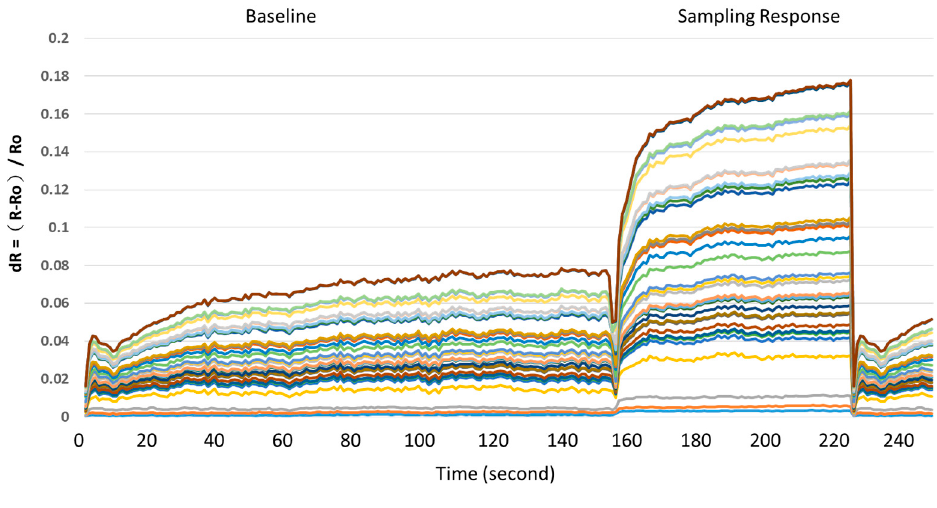
Figure 2. Sensors response ratio.